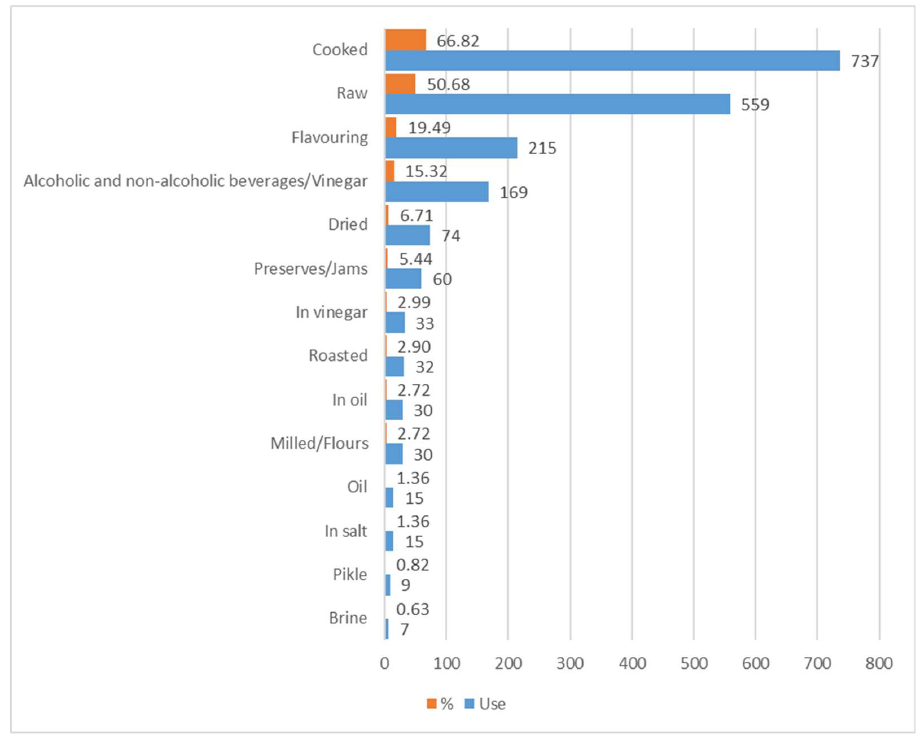
Figure 11. Methods for use of edible species and their frequency in the whole database.